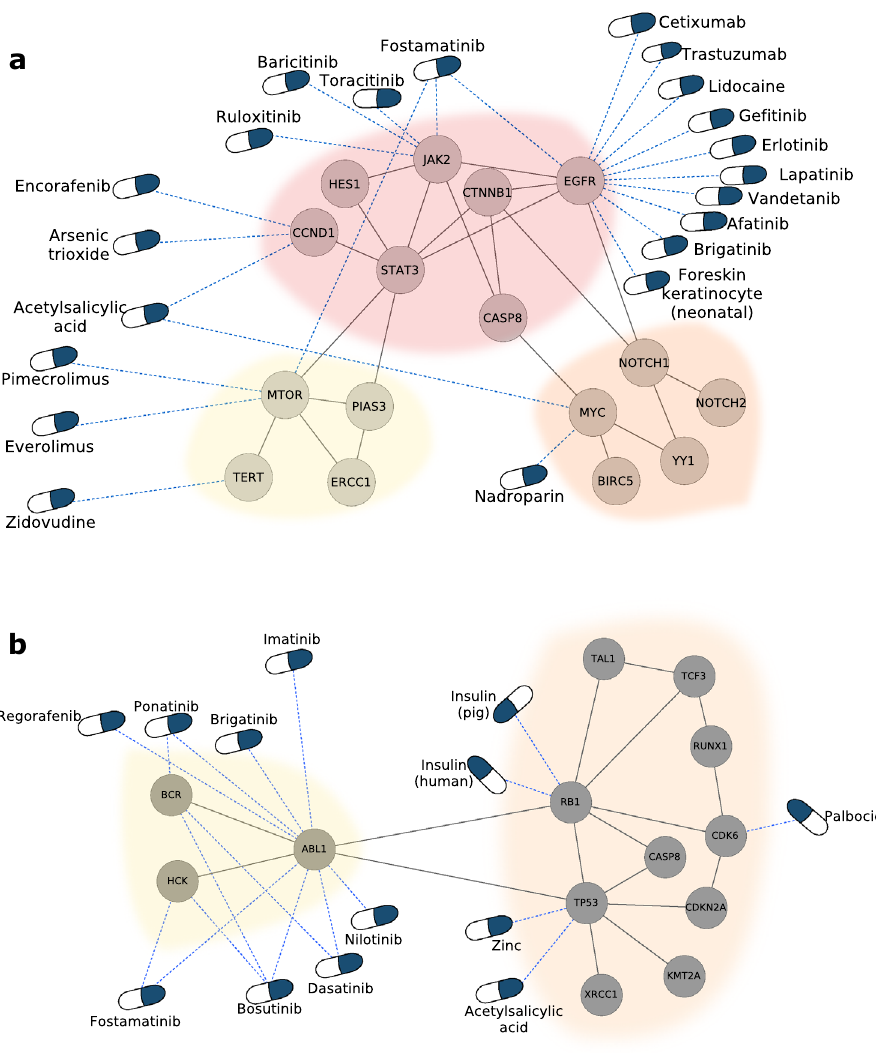
Figure 5. Network examples of disease module targeting by drugs. ( a ) Disease modules for uterine cervical neoplasm accompanied by the drugs that target them. The biggest module is the one associated with most drugs. There are two polypharmacological drugs: Acetylsalicylic acid and Fostamatinib, both of them targeting two out of the three disease modules. ( b ) Disease modules for childhood acute lymphoblastic leukemia with the drugs that target them. In this case the smallest module is the one associated with most drugs. There are four polypharmacological drugs (Ponatinib, Fostamatinib, Bosutinib and Dasatinib), all of them associated only with the small